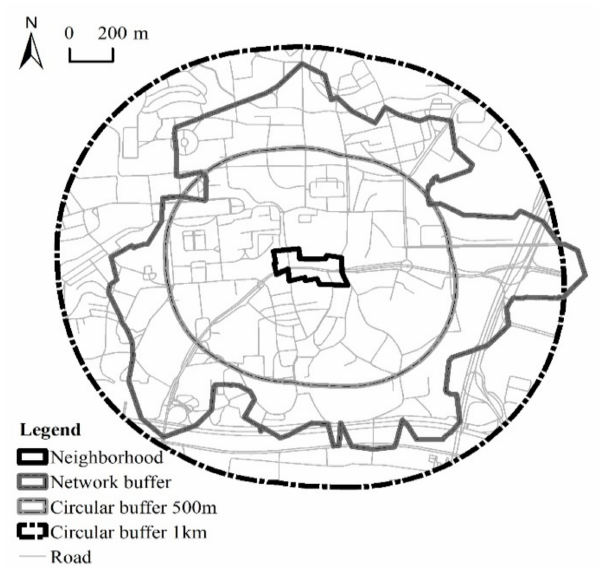
Figure 2. Three di ff erent bu ff er areas of one sampled neighborhood